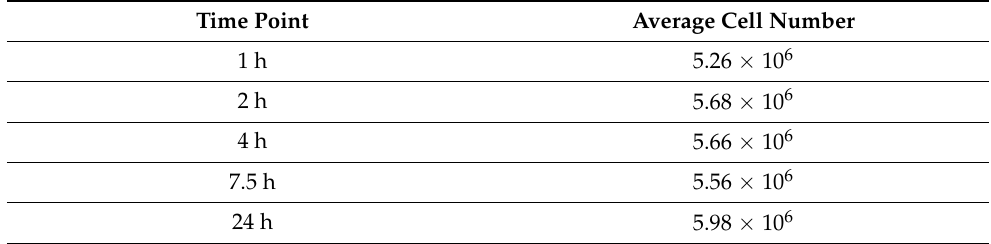
Table 1. Number of viable cells repeatedly counted during the